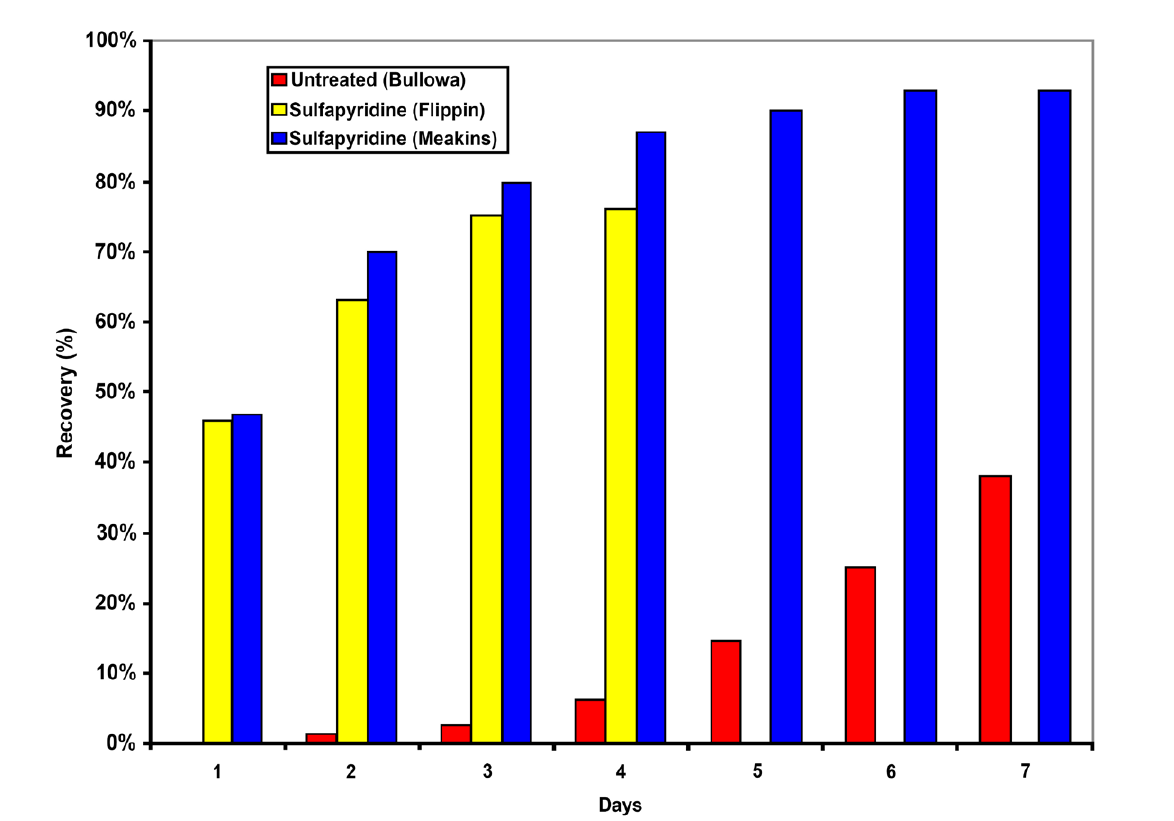
Figure 2. Antibacterial Treatment Effect on Clinical Recovery from Pneumococcal